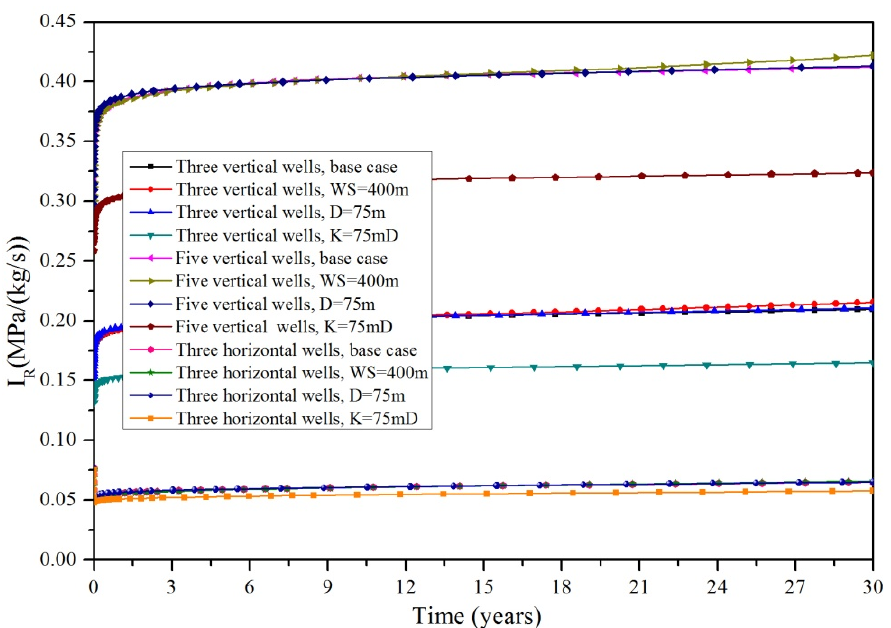
Figure 12. Sensitivity of reservoir impedance to main parameters.